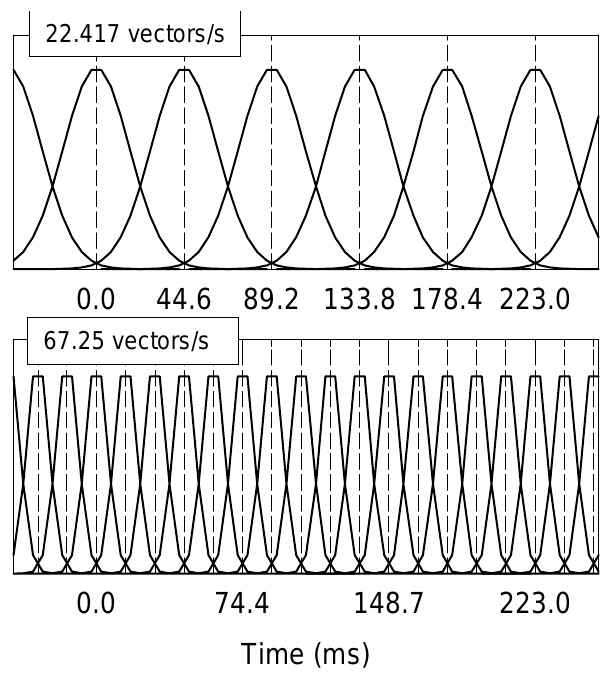
Fig. 2. Gaussian digital filtering of the full resolution sampling at 201.75 vectors/s of the magnetic field. The two most frequently used vector sampling rates are